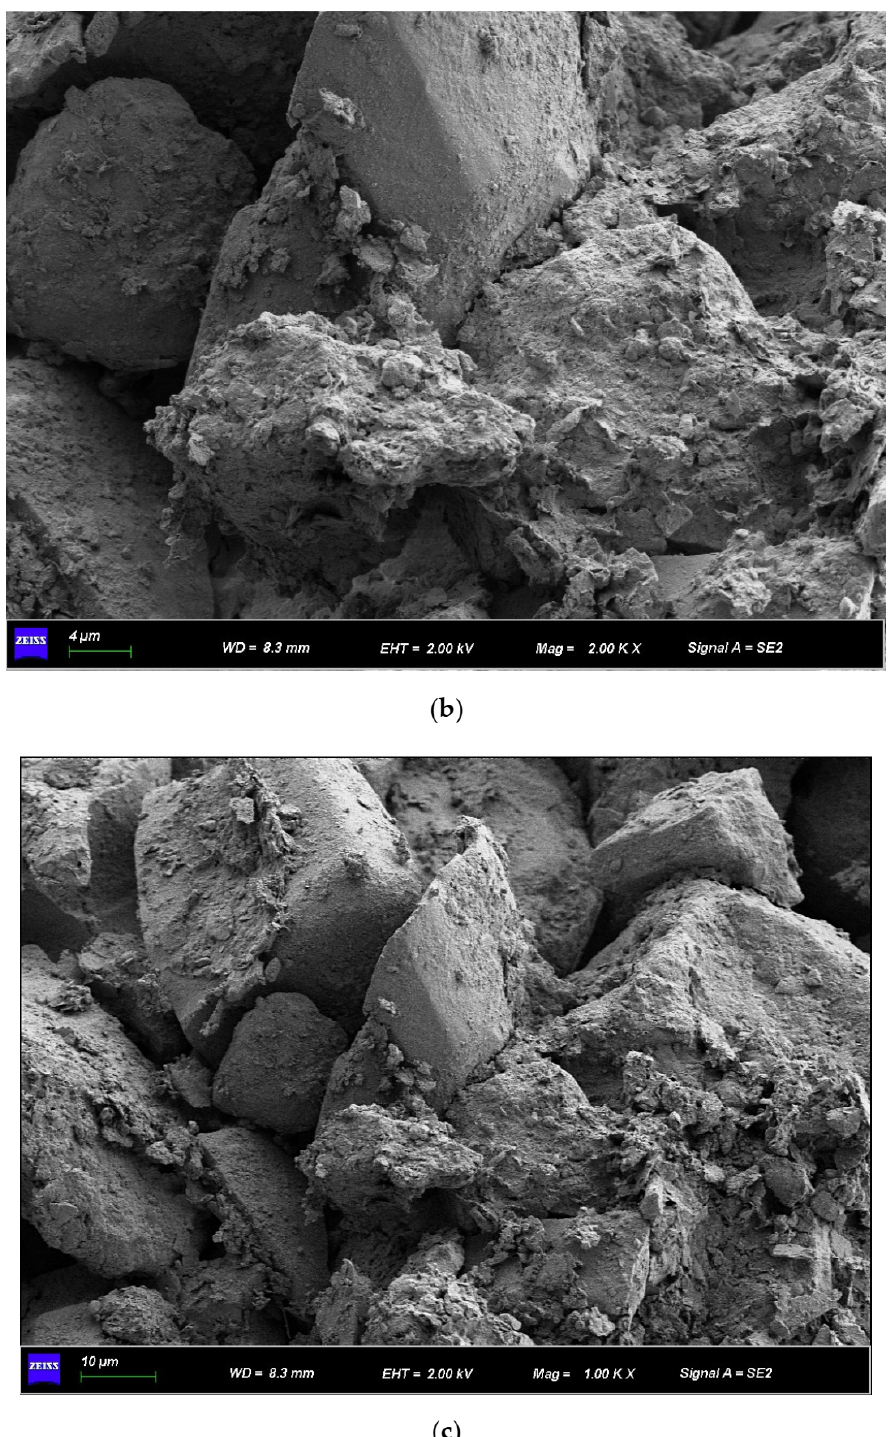
Figure 12. SEM micrographs of the blank control group at different magnifications. ( a ) 2 µ m; ( b ) 4 µ m; ( c ) 10 µ